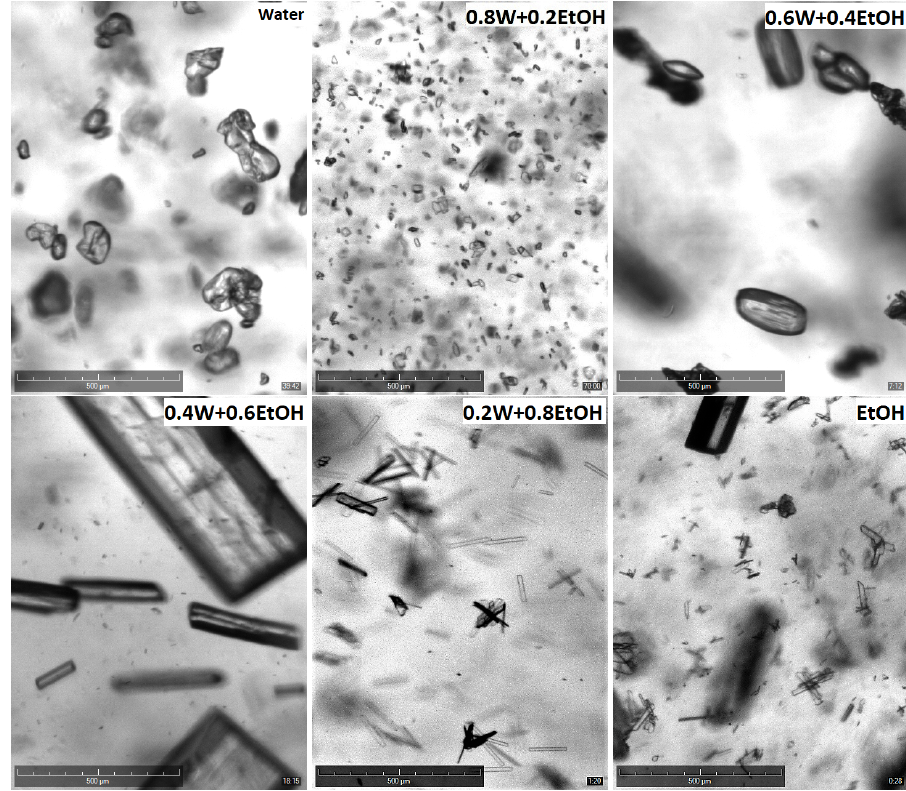
Figure 12. Images of ascorbic acid crystals in water-ethanol solvent systems (scale: 500 µ m).